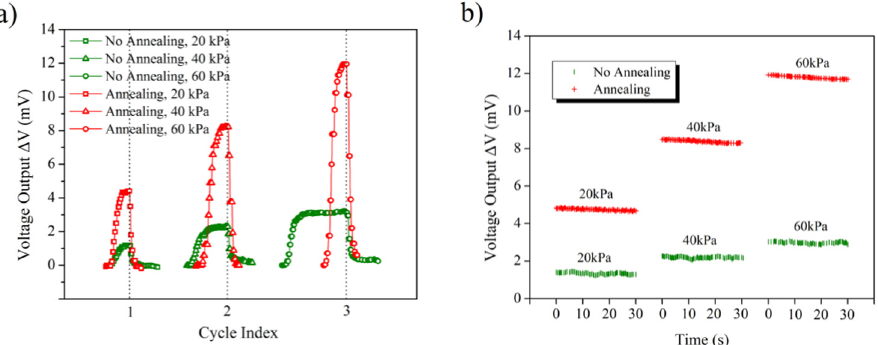
Figure 8. Dynamic voltage output: ( a ) voltage output during cycling tests when switching the differential pressure ON/OFF; ( b ) voltage output versus time under differential pressure with step increase from 20 kPa to 60 kPa (20 kPa per step).